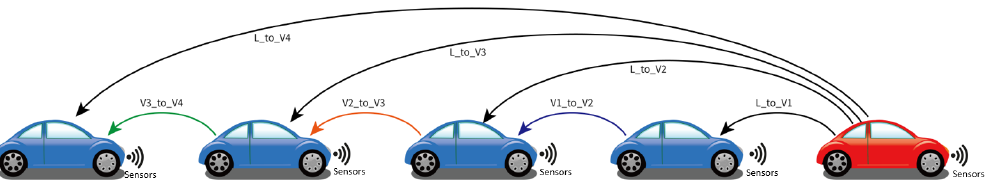
Figure 7. Example of platooning system.